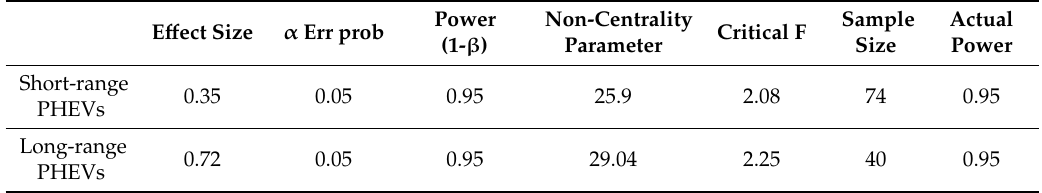
Table A1. A-priori Test: Compute sample size for a given α , power, and e ff ect